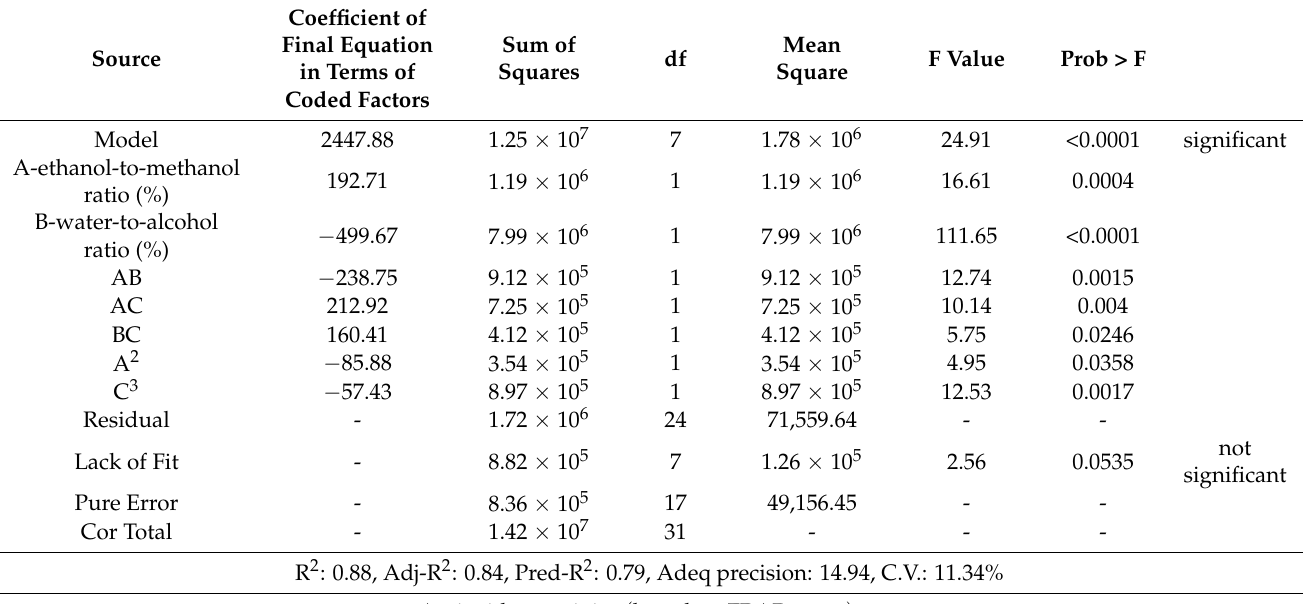
Table 6. The analysis of variance (ANOVA) of antioxidant activity in terms of ferric reducing antioxidant power (FRAP) assay (third-order fitted polynomial model) in bioactive compounds extraction of eggplant peel by the different solvent combination.